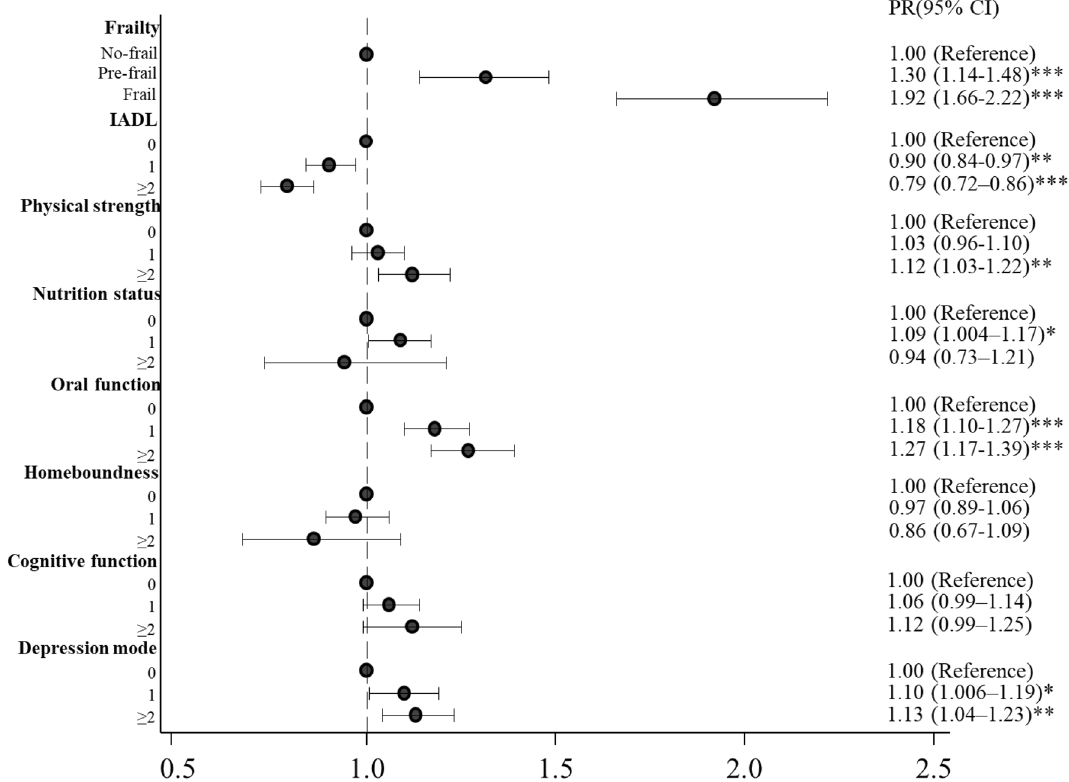
Figure 1. Prevalence ratios (PR) and 95% confidence intervals (95% CI) of associations between the occurrence of pneumonia and frailty or each of the Kihon checklist (KCL) categories in community-dwelling older adults. Numbers in KCL scores represent how many questions were applicable to older adults. * p < 0.05, ** p < 0.01, *** p < 0.001. IADL, Instrumental Activity of Daily